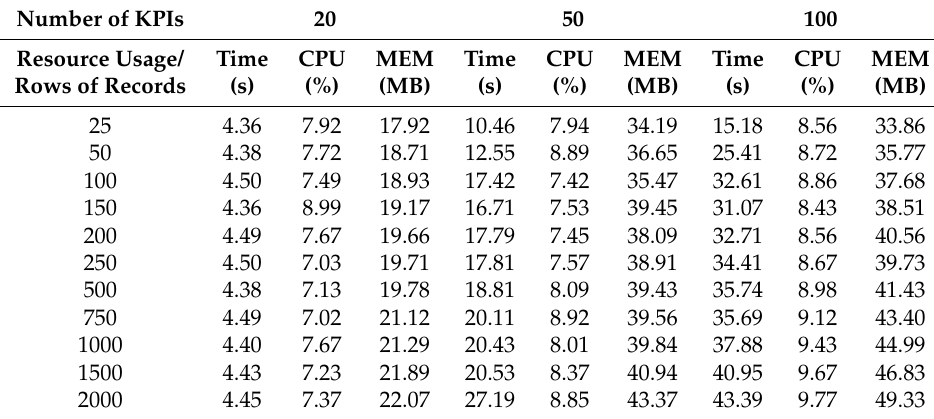
Table 3. Overhead of the